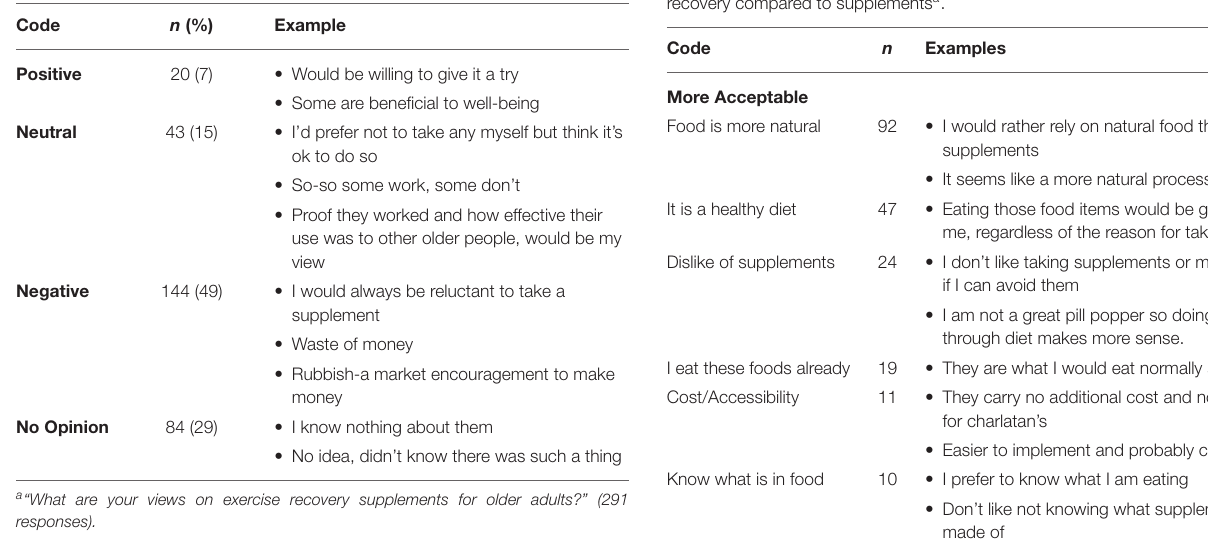
TABLE 2 | Older adults’ views on exercise recovery supplements a . TABLE 3 | Older adults’ reasons for the acceptability of whole foods for exercise